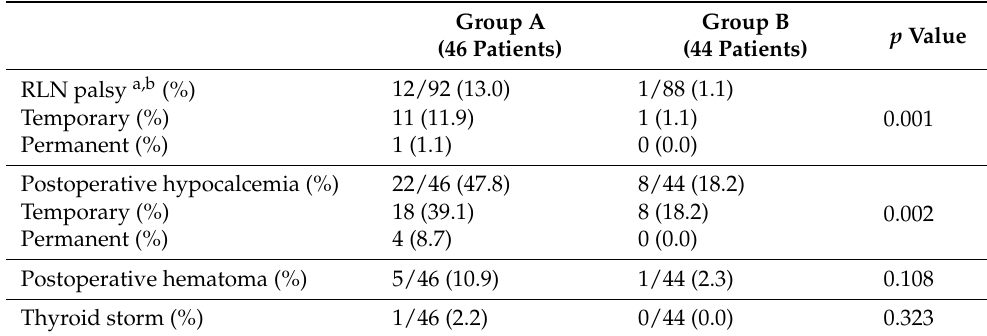
Table 2. Major complications of total thyroidectomy in Graves’ Disease.